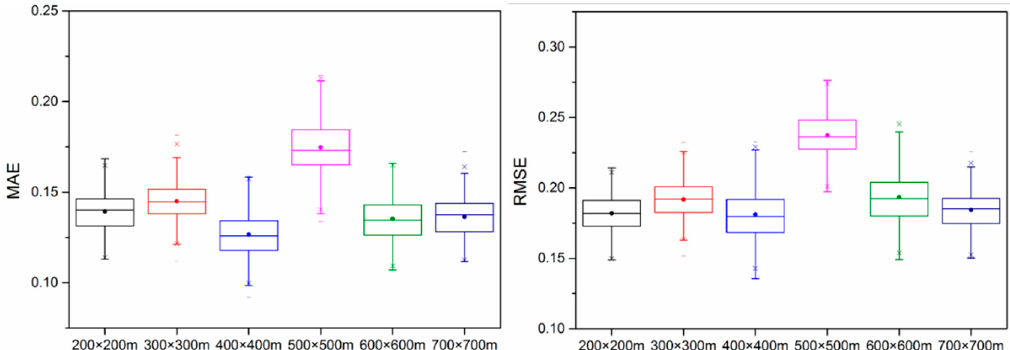
Figure 5. The MAE and RMSE results for the SOM content mapping, using different sized super-grids that range from 200 × 200 m 2 to 700 × 700 m 2 .